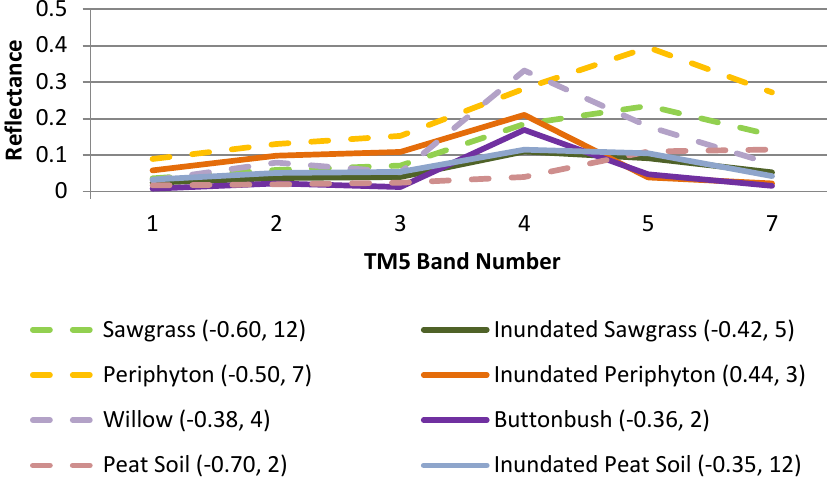
Figure 3. The result of resampling the spectra shown in Figure 2 to TM5 band reflectances.